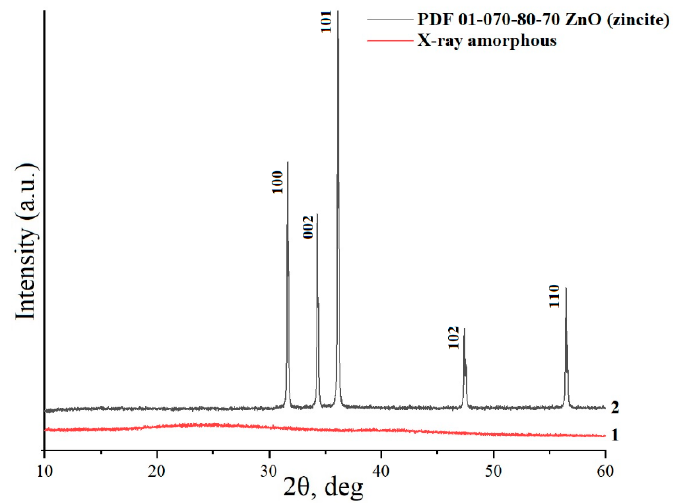
Figure 1. X-ray powder diffraction patterns of sample 1 (line 1) and sample 2 (line 2).